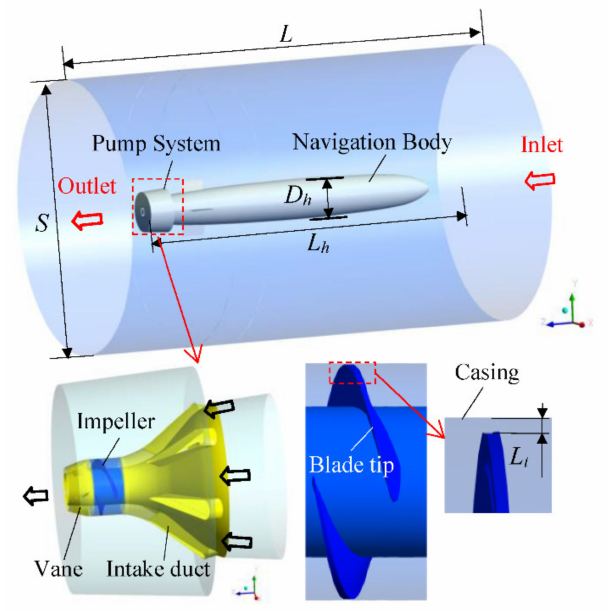
Figure 1. Computational domain of the underwater